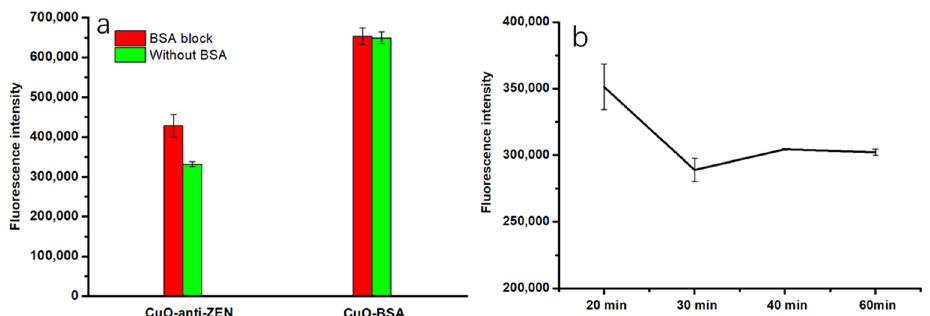
Figure 3. The study of nonspecific adsorption between MB-ZEN-BSA and CuO NP-anti-ZEN with and without BSA (the reaction time is 10 min) ( a ) and the reaction time optimization between MB- ZEN-BSA (5 mg/mL, 10 μ L) and CuO NP-anti-ZEN (1 mg/mL, 5 μ L) ( b